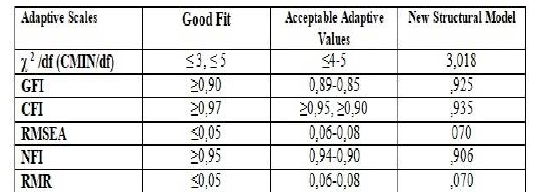
Table 5. Model Adaptive Values